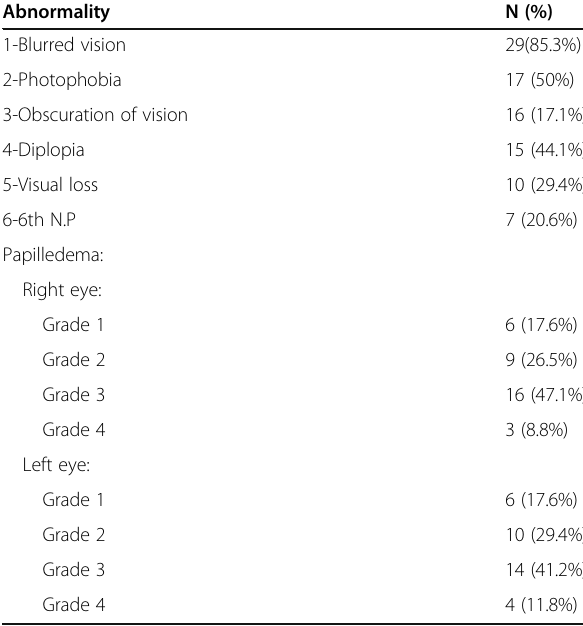
Table 3 MRI and MRV findings in discriminating IIH cases from